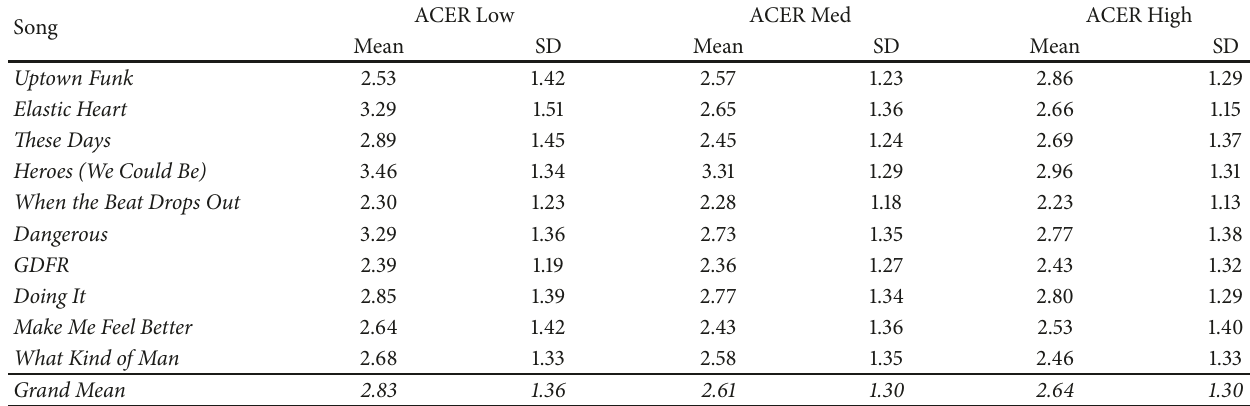
Table 4: Summary noise and distortions scores: ACER low, ACER medium, and ACER high (n = 68). A score of 1 represents imperceptible noise and distortions and a score of 5 represents perceptible noise and distortions.